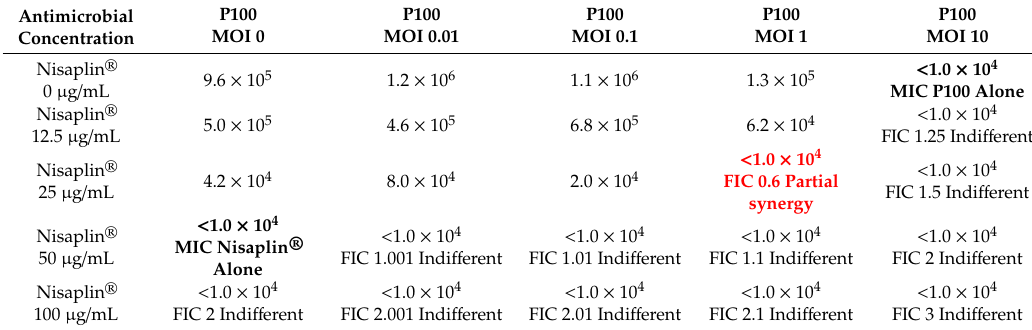
Table 2. ScottA CFU / mL during P100 and Nisaplin ® checkerboard assay in coleslaw. MIC of P100 alone and Nisaplin ® alone are shown in bold. FIC values were calculated. FIC index results are interpreted as follows: FIC ≤ 0.5 is synergy, 0.5 < FIC ≤ 0.75 is partial synergy, 0.75 < FIC ≤ 1.0 is additive, FIC >